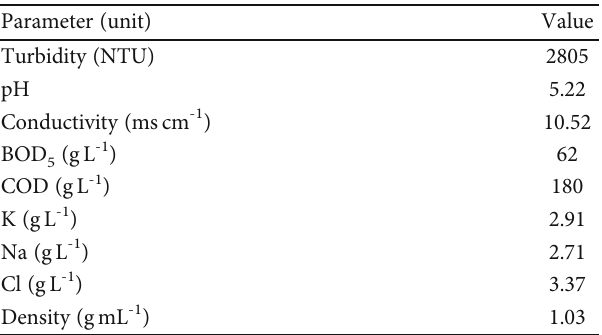
Table 2: Physicochemical characterization of EOMW used in the corrosion tests.